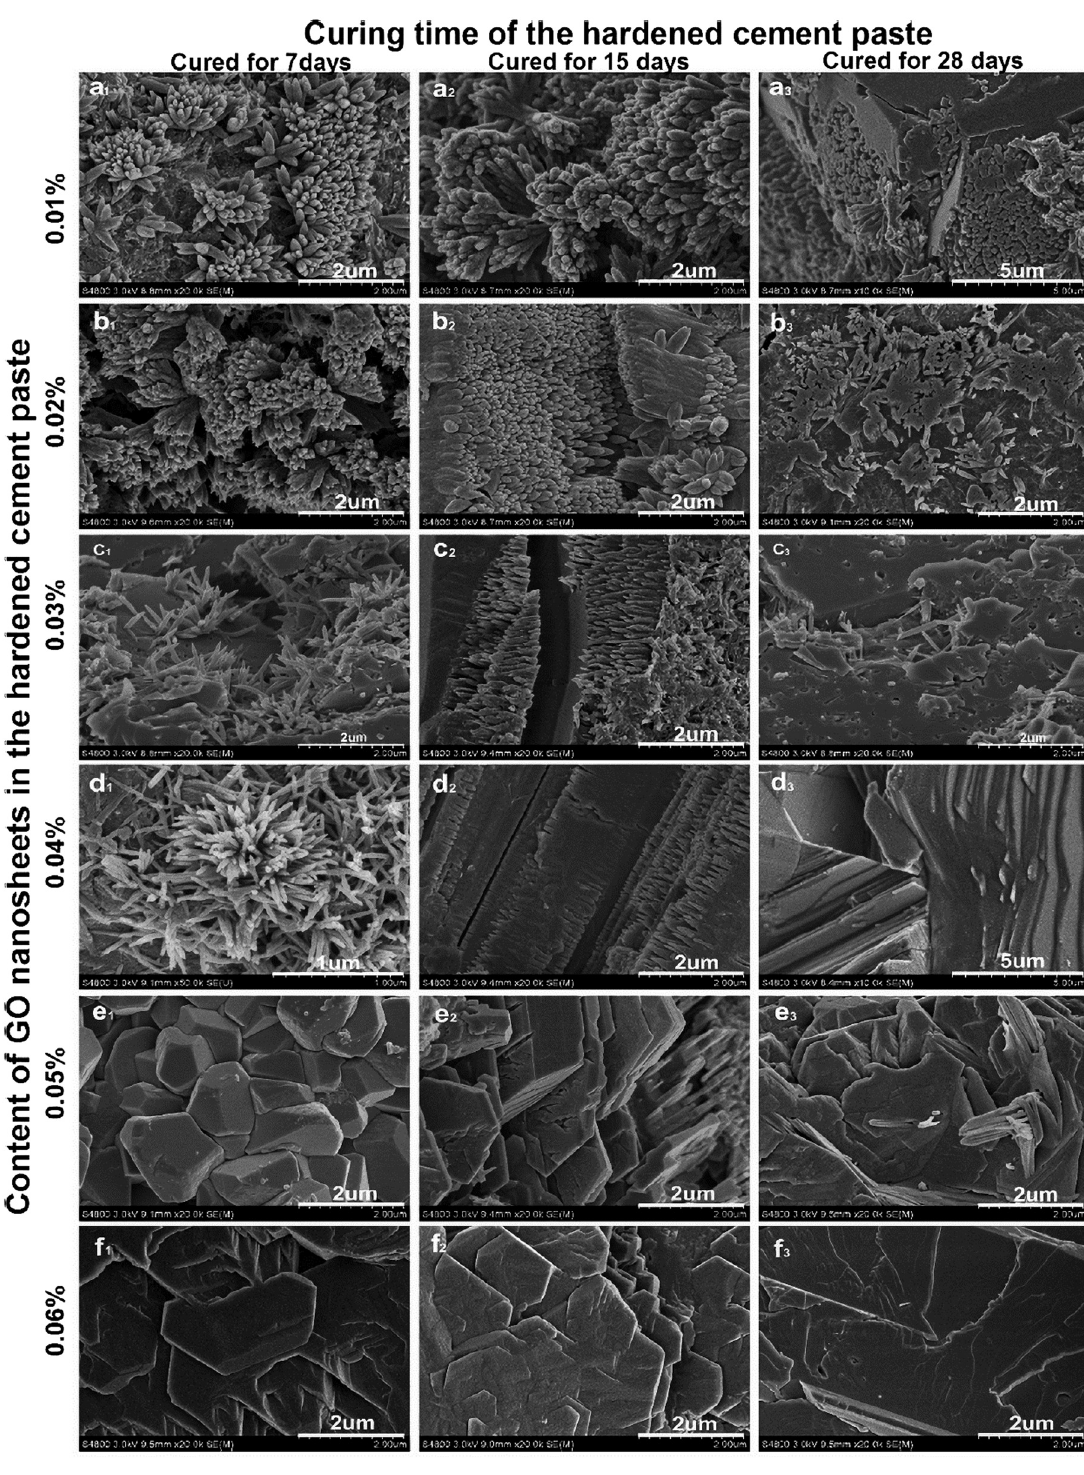
Figure 15: SEM images of the fracture surfaces of the hardened cement pastes with di ff erent GO contents at 7 days, 15 days and 28 days. GO contents: ( a ) 0.01%; ( b ) 0.02%; ( c ) 0.03%; ( d ) 0.04%; ( e ) 0.05%; and ( f ) 0.06% bwoc [ 81 ]